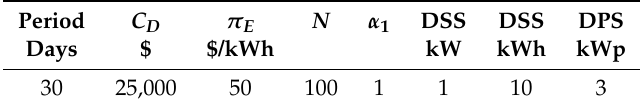
Table 2. Simulation